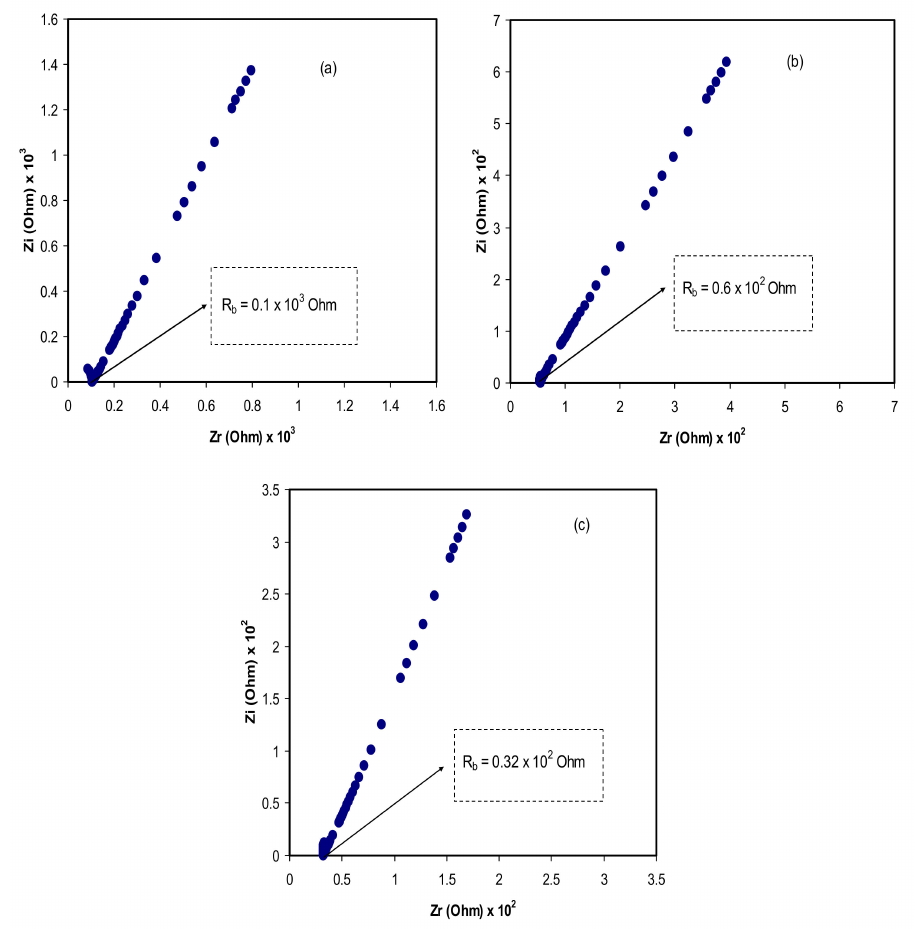
Figure 4. Complex impedance plots for ( a ) CSGL 1, ( b ) CSGL 2, and ( c ) CSGL